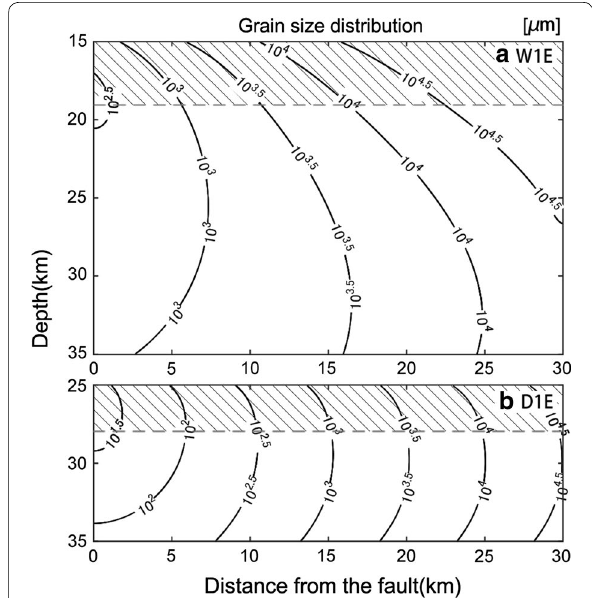
Fig. 5 Contours of equilibrium grain size distribution as a function of depth and distance from the fault, calculated from model W1E ( a ) and D1E ( b ). The gray broken line represents the BDT depth